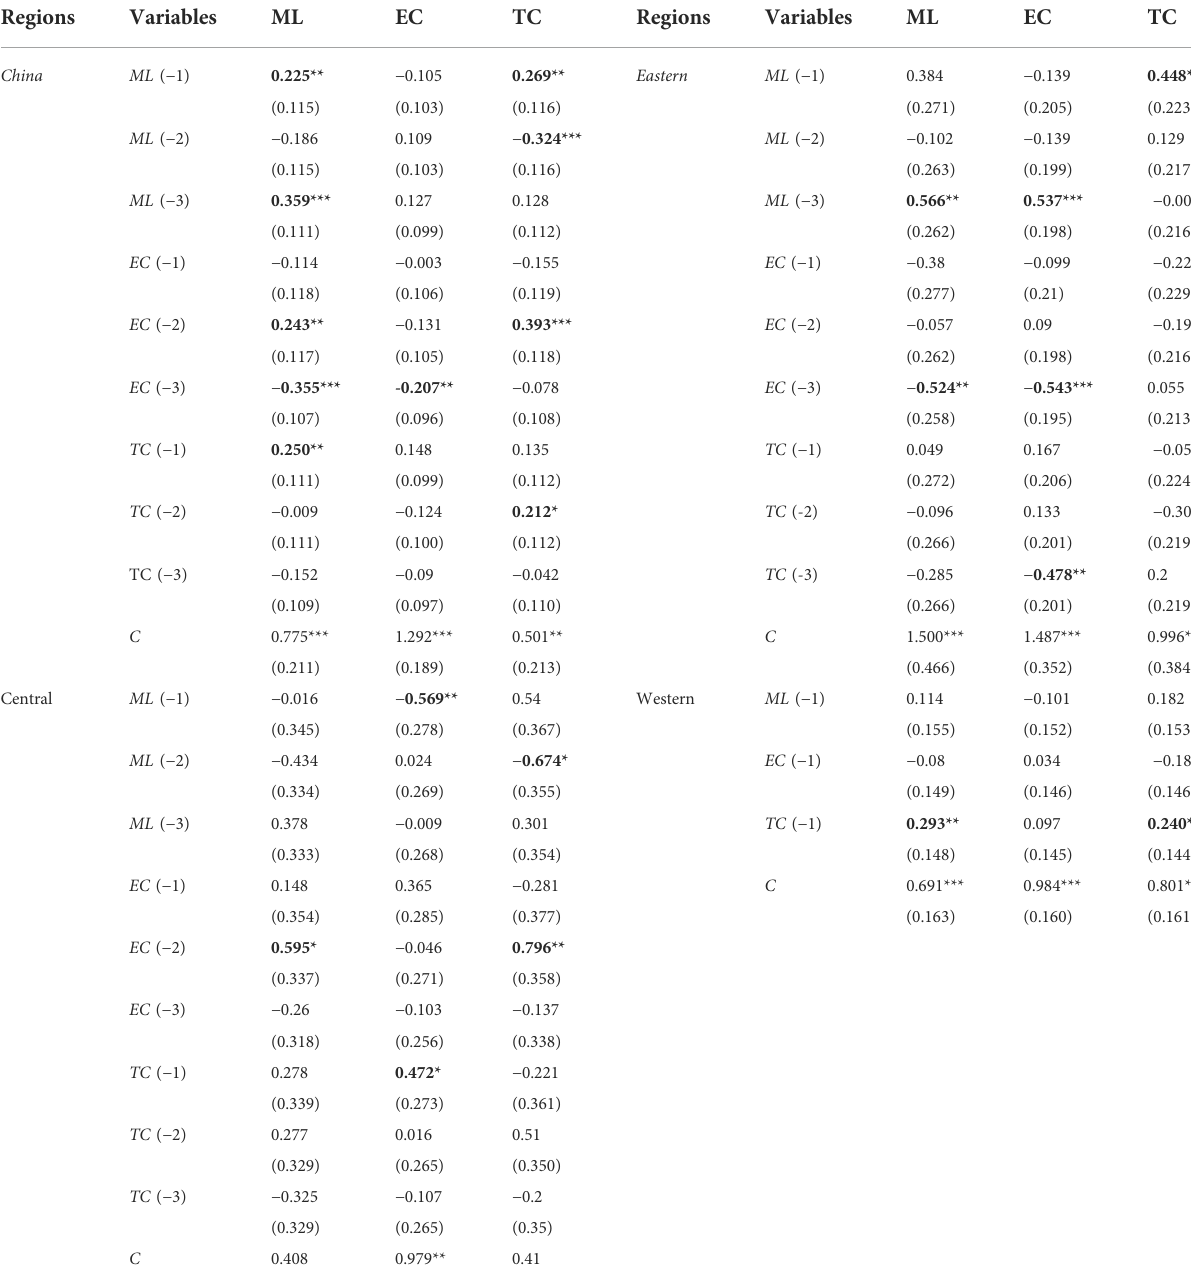
TABLE 8 Regression results of PVAR